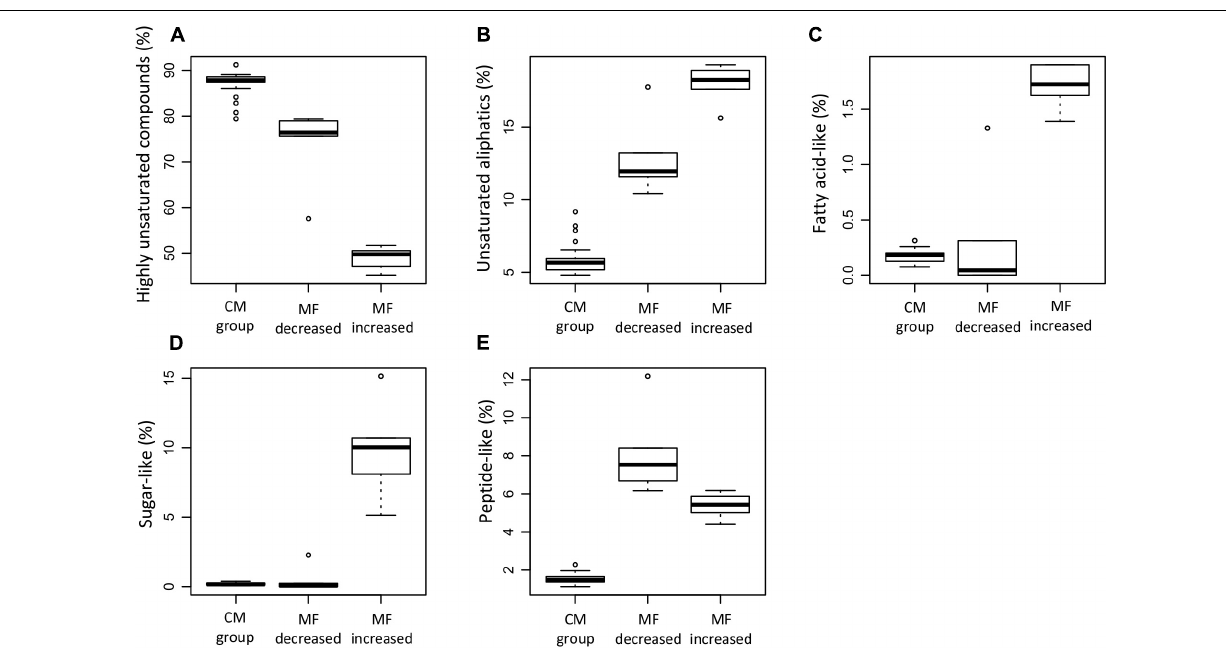
FIGURE 11 | Box plots summarizing the relative abundance of specific DOM molecular classes of the molecular formulae that significantly decreased (MF dec., n = 315), the molecular formulae that significantly increased (MF inc., n = 254), and the molecular formulae in the conservative mixing group (CM group, n = 13,462). The information corresponds to the averages weighted by FT-ICR-MS signal intensity for each of the samples. The DOM molecular classes shown correspond to highly unsaturated compounds (A) , unsaturated aliphatics (B) , fatty acid-like (C) , sugar-like (D) , and peptide-like (E) . For definition of DOM molecular classes, please refer to section molecular analysis of DOM in materials and